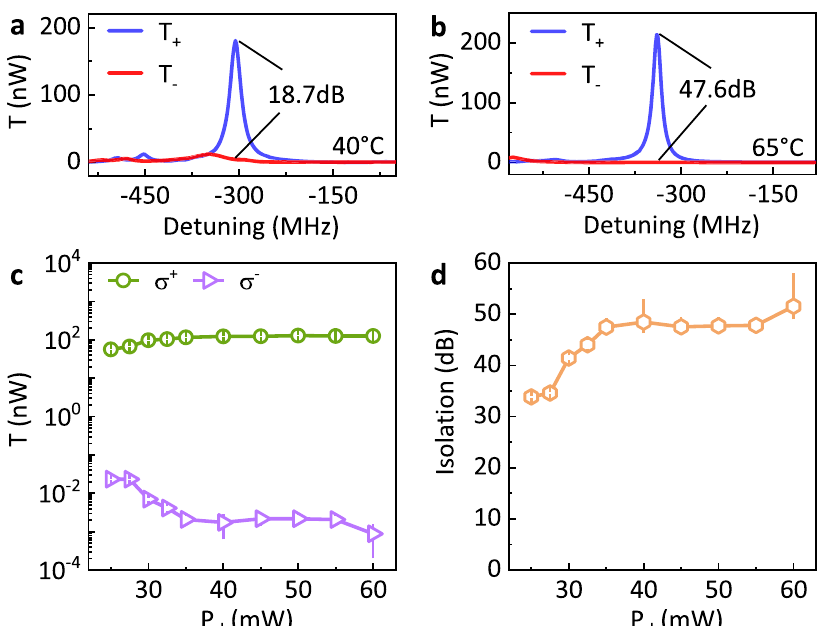
Fig. 3 Optical isolation via absorptive non-reciprocity. a , b Typical transmission spectra for σ + and σ − -polarized signals at different atomic densities, with the temperature of the atomic cell respectively set at 40 ∘ C and 65 ∘ C and the corresponding isolation ratios 18.7 dB and 47.6 dB, respectively. Here, the signal and drive power is fi xed at P s = 50 μ W and P d = 45 mW, respectively. c The on-resonant transmitted signal power vs the drive laser power ( P d ). The green and purple spots represent the σ + and σ − -polarized signals, respectively. d Extracted isolation ratio at different P d . The largest isolation ratio dB is achieved at P d = 60 mW. The results in c and d are measured at 65 ∘ C with a fi xed signal laser power of P s = 50 μ W, and error bars denote 51 : 5 þ 6 : 5 (cid:2) 2 : 5 standard